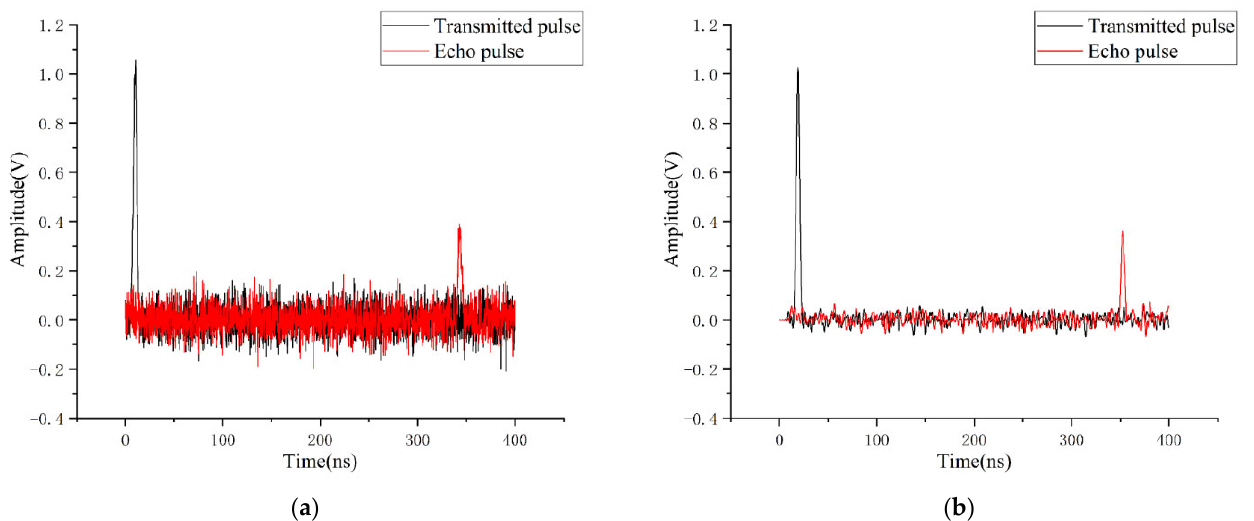
Figure 2. ( a ) Transmitted and echo pulse signal; ( b ) Transmitted and echo pulse signal after FIR.